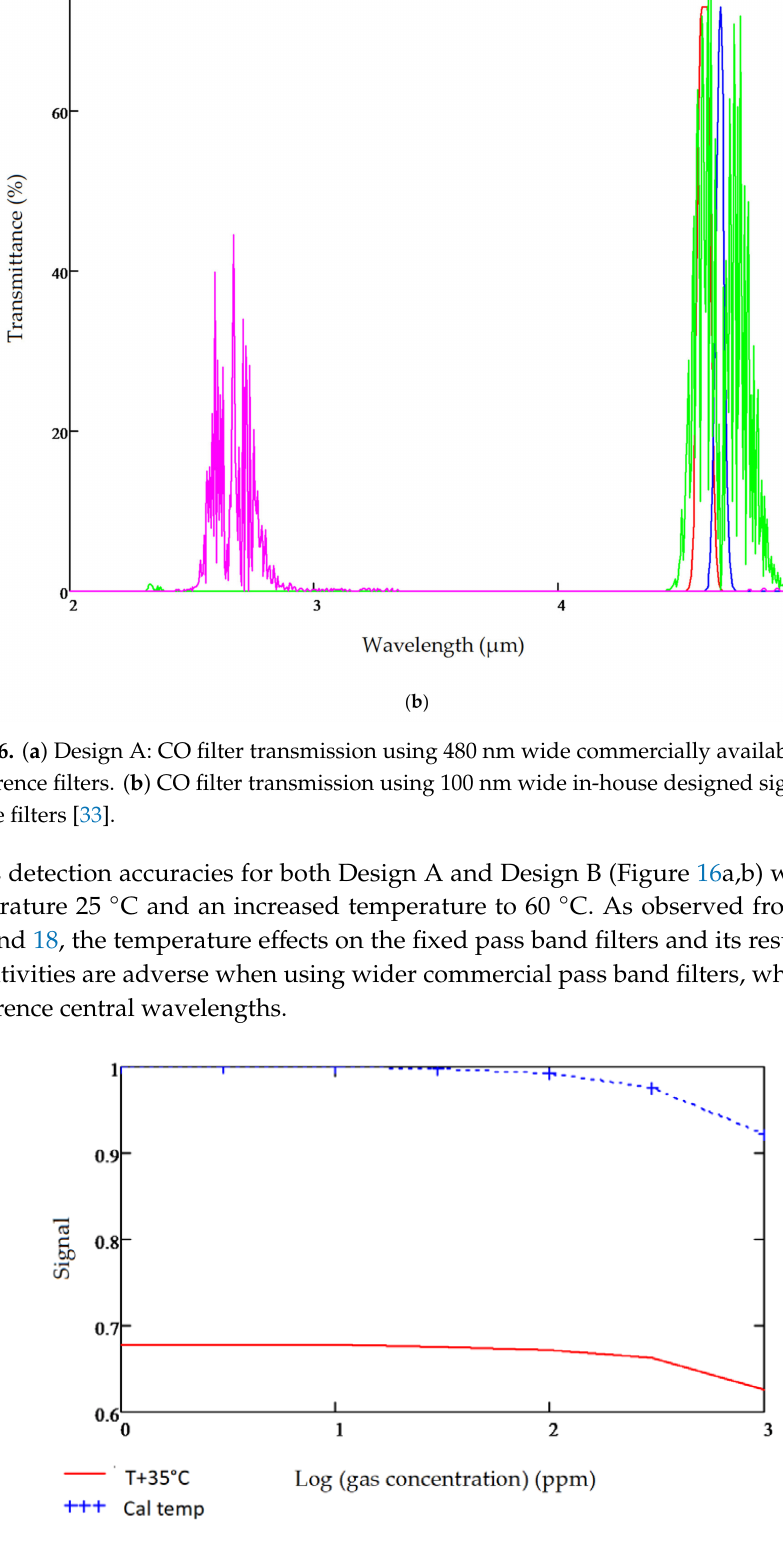
Figure 17. Design A: Detected lead selenide output with commercial signal and reference